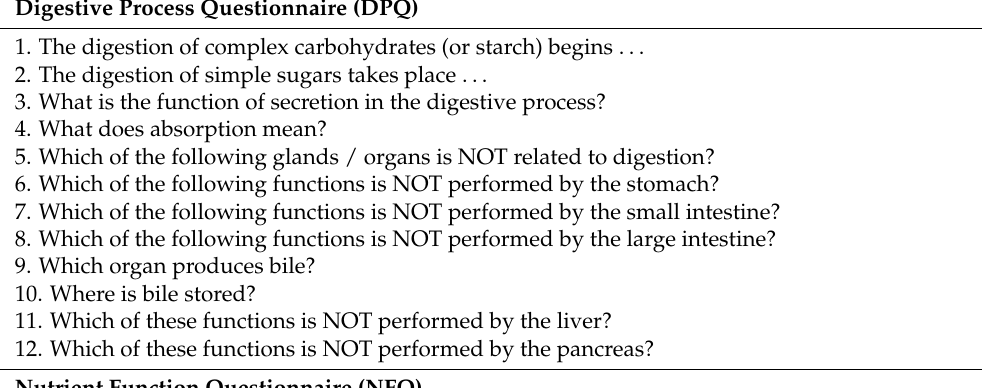
Table 1. Multi-choice questionnaires used to assess students’ knowledge on different nutrition-related issues. Digestive Process Questionnaire